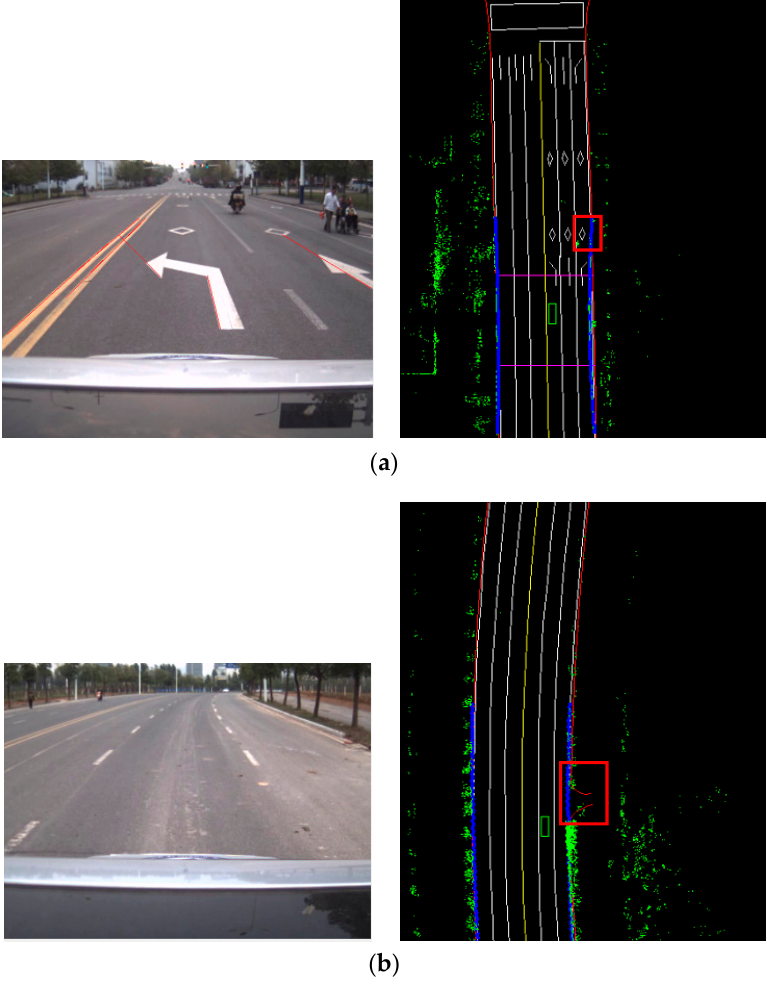
Figure 25. Result of curb detection in typical scenes. ( a ) Straight road; ( b ) Winding road.